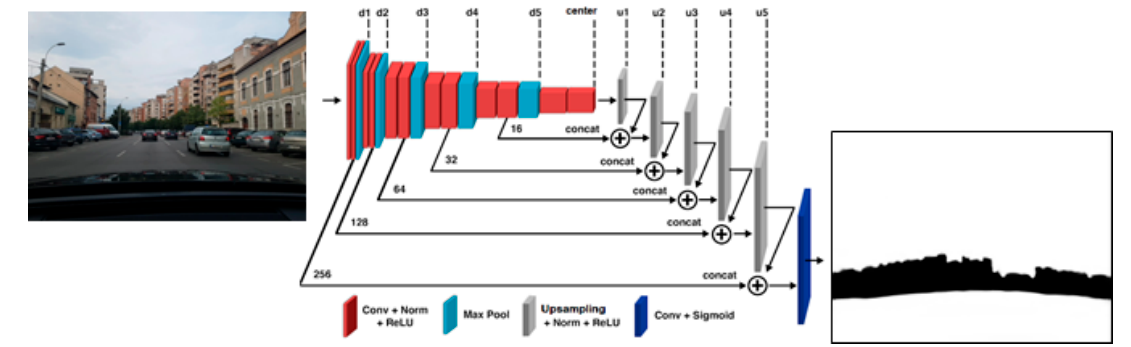
Figure 3. Segmenting the scene using the U ‐ Net convolutional neuronal network.